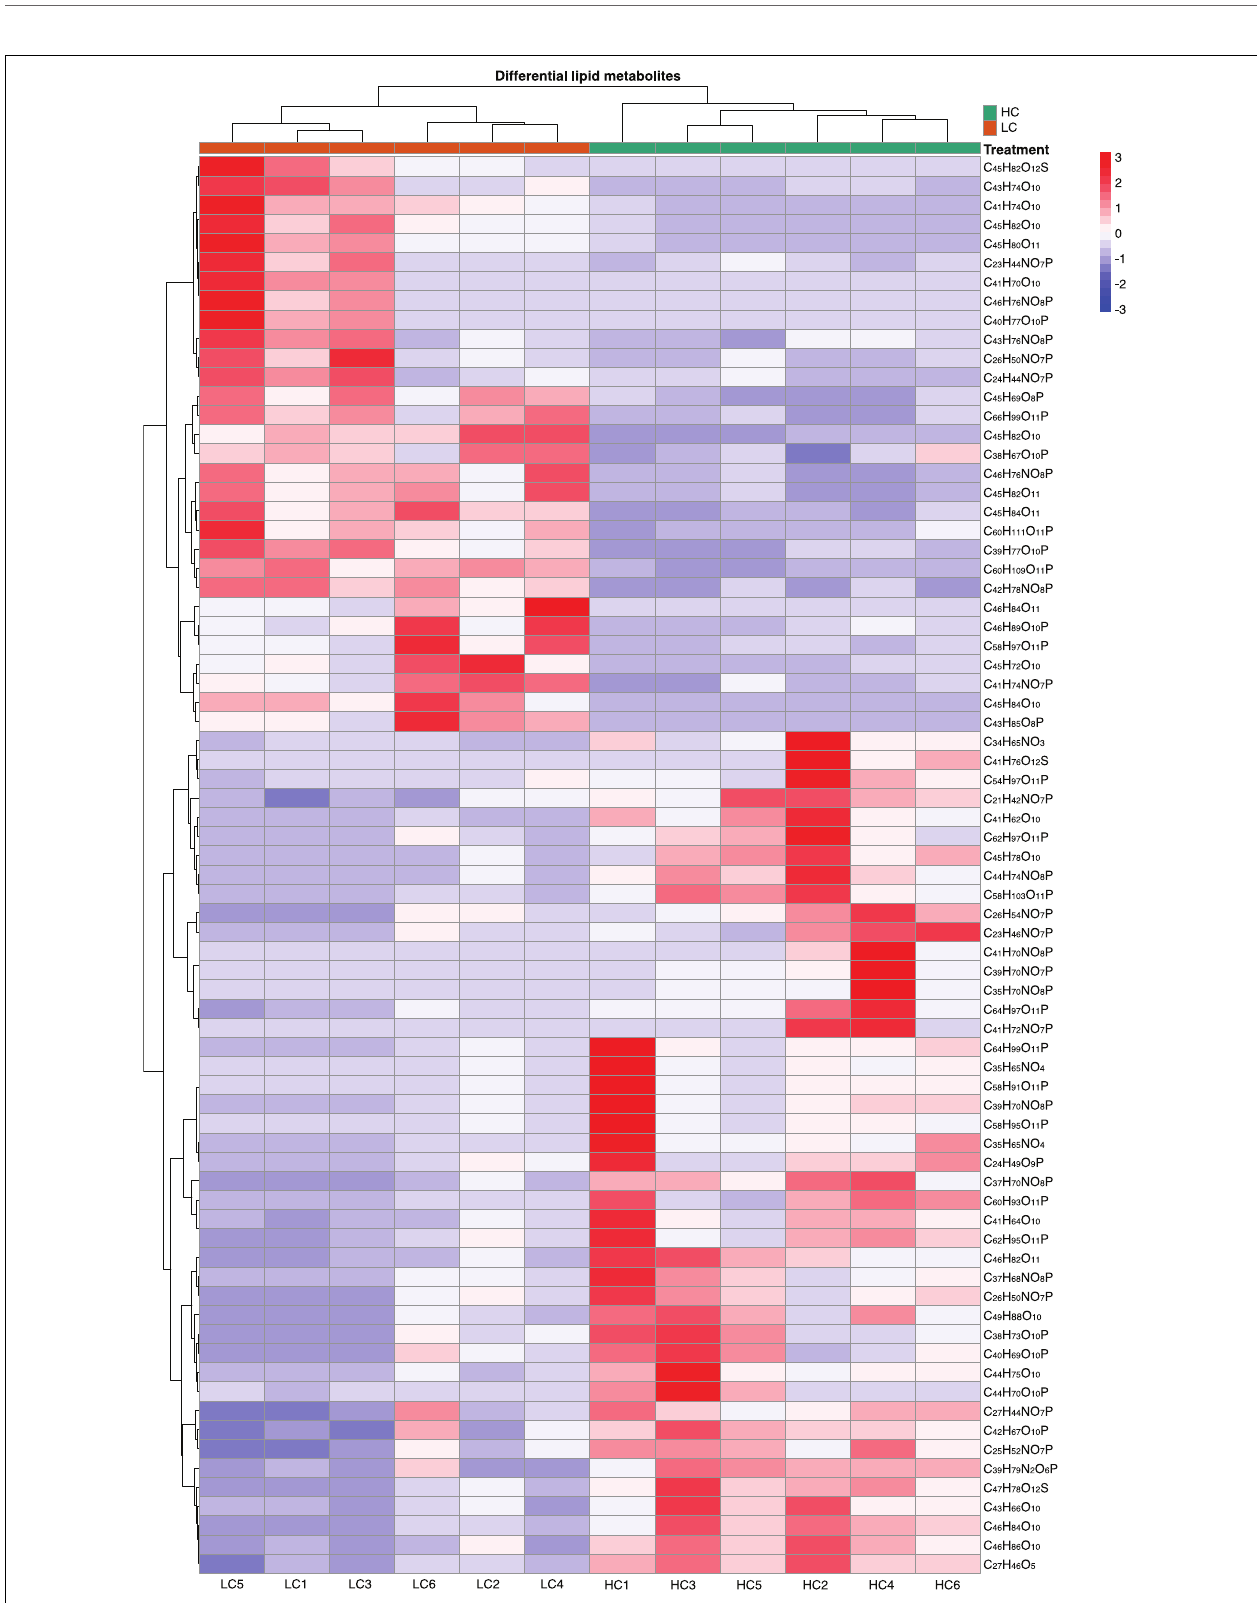
Frontiers in Microbiology |